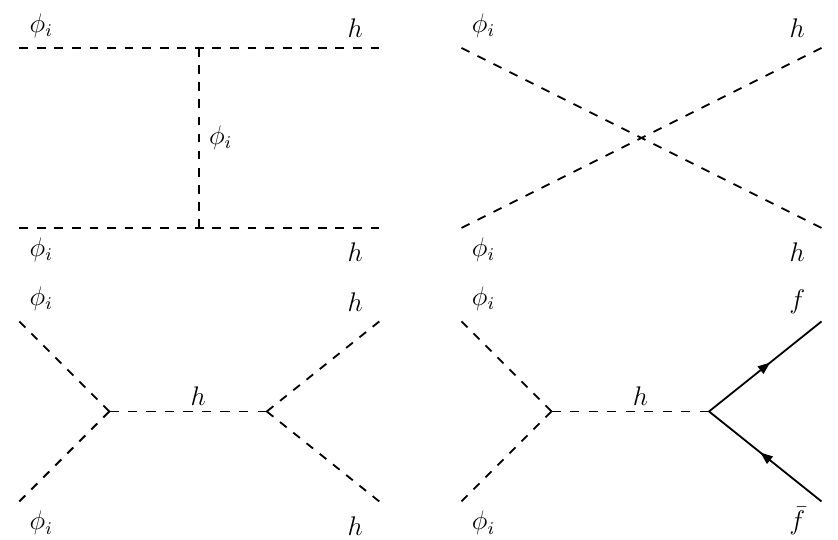
Figure 9 . DM annihilation channels via cubic and quartic interactions with the Higgs. Notice that one more diagram is present by replacing the SM fermions with the SM gauge